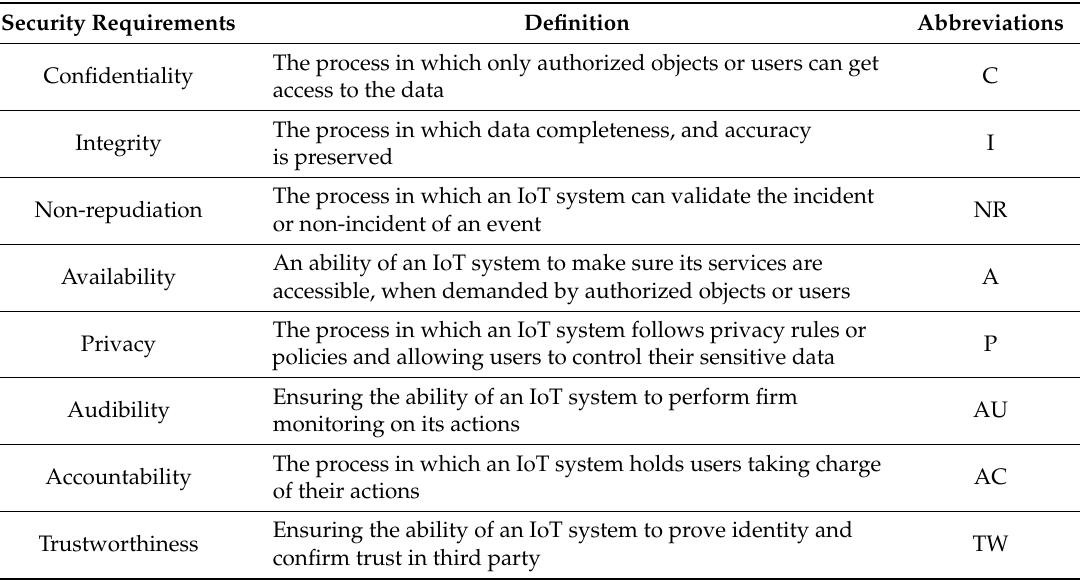
Table 2. Internet of Things (IoT) Security goals